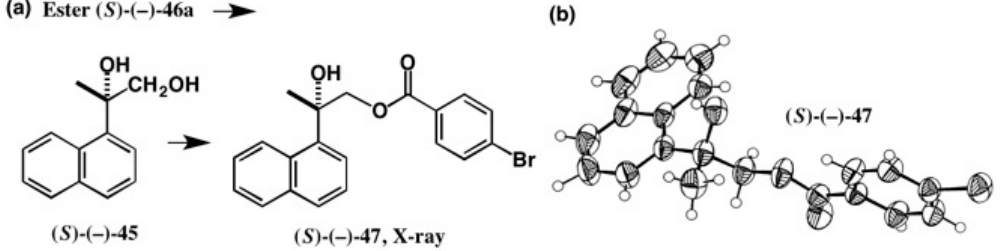
Figure 32. Preparation ( a ) of p -bromobenzoate ( S )-( − )- 47 and its X-ray analysis ( b ). ORTEP drawing, reprinted from [50].